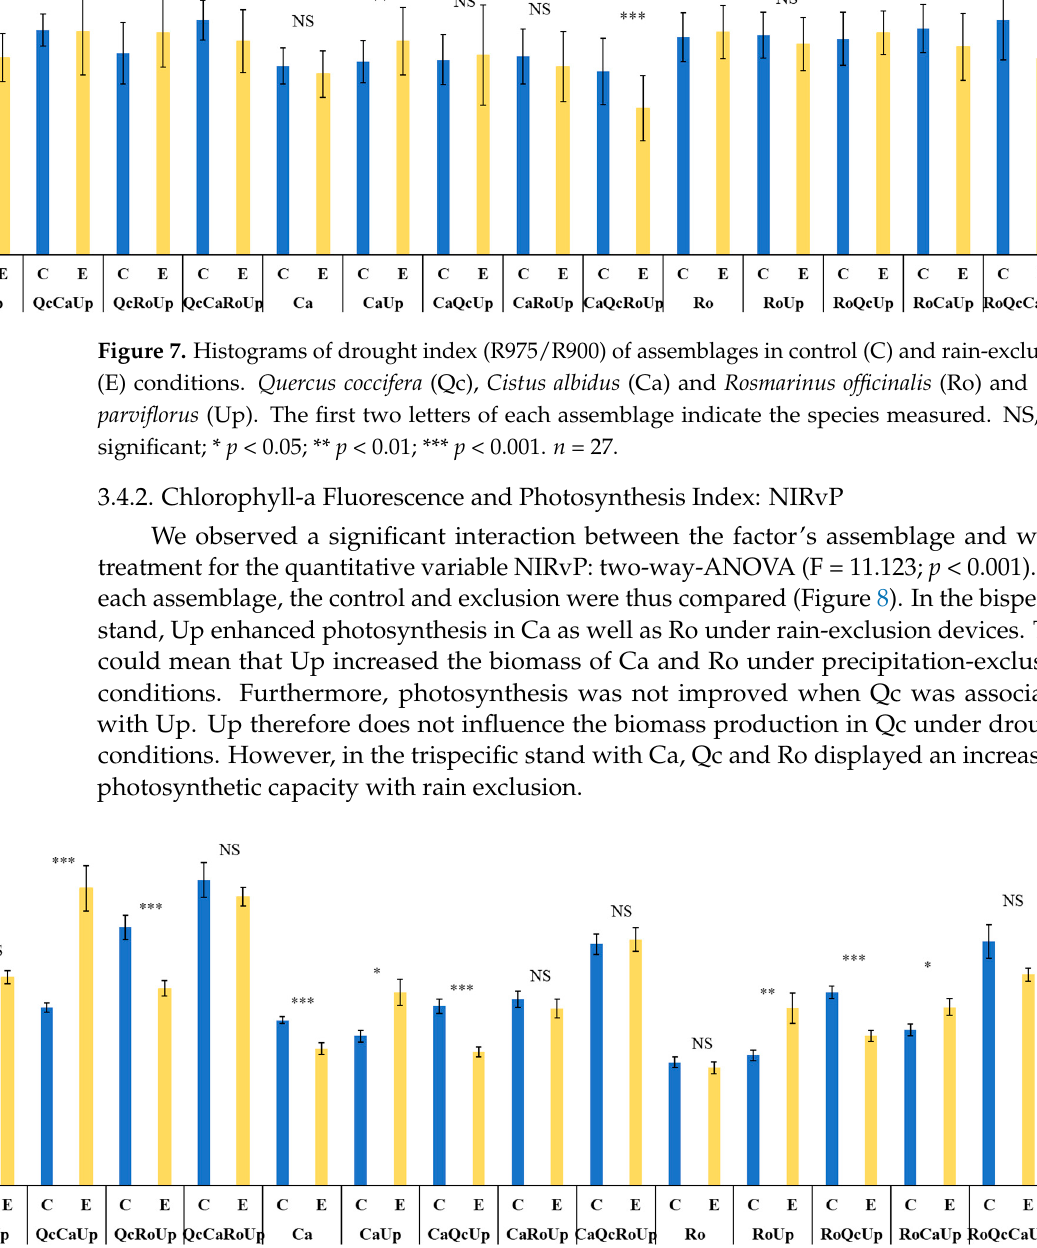
Figure 8. Histograms of photosynthesis and fluorescence index (NIRvP) of assemblages in control (C) and rain-exclusion (E) conditions. Quercus coccifera (Qc), Cistus albidus (Ca) and Rosmarinus offic- inalis (Ro) and Ulex parviflorus (Up). The first two letters of each assemblage indicate the species measured. NS, not significant; * p < 0.05; ** p < 0.01; *** p < 0.001. n = 27 .